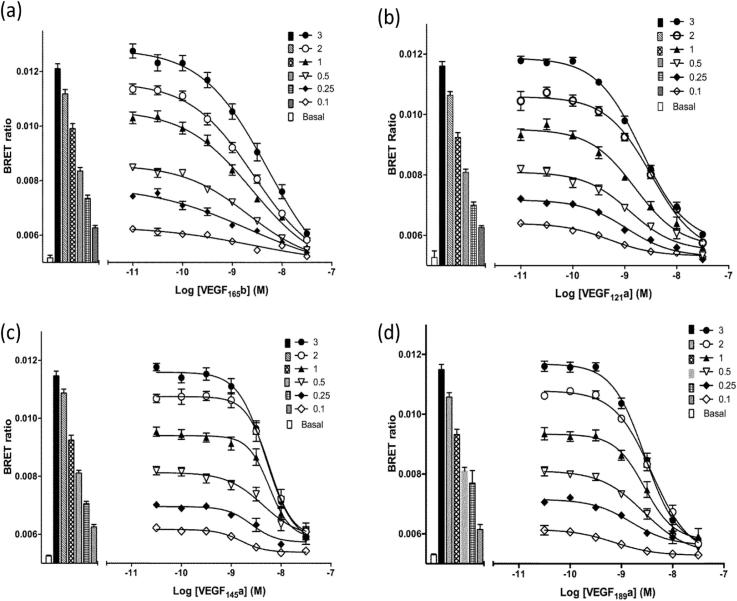
Inhibition of the binding of VEGF165a-TMR to NLuc-VEGFR2 by unlabeled VEGF isoforms. Fixed concentrations of VEGF165a-TMR (0.1–3 nM) were added simultaneously with increasing concentrations of (a) VEGF165b, (b) VEGF121a, (c) VEGF145a and (d) VEGF189a, and incubated for 1 h at 37 °C. Data represent mean ± S.E.M of 5 independent experiments, each performed in triplicate. Bars represent the binding of VEGF165a-TMR obtained at each fluorescent ligand concentration in the absence of competing ligand. The open bar shows the BRET ratio obtained in the absence of VEGF165a-TMR.